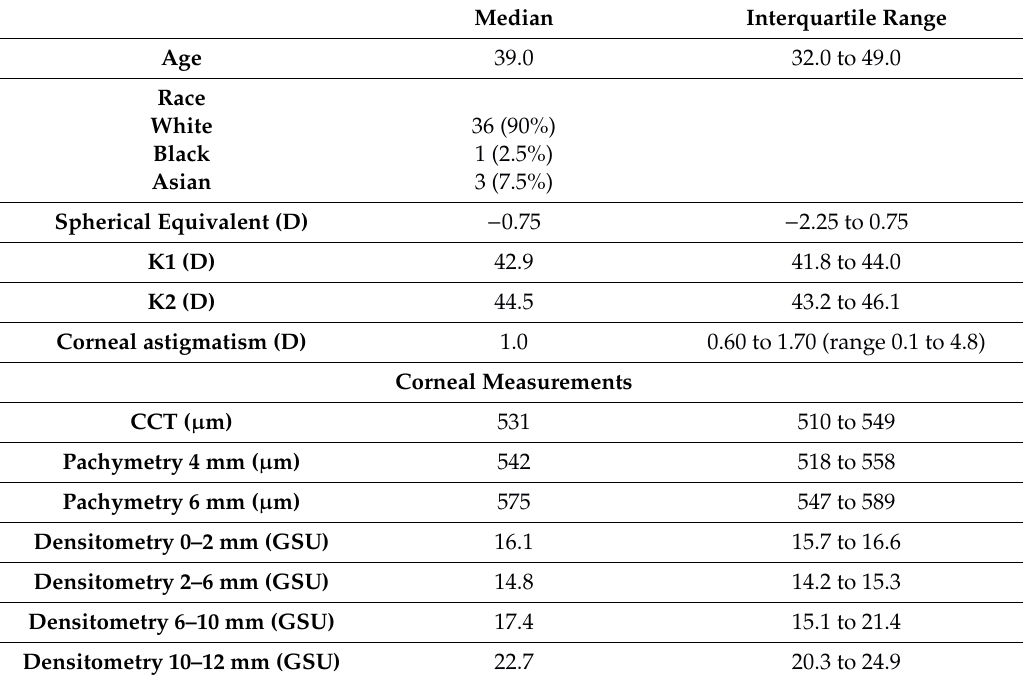
Table 1. Demographic and clinical characteristics of included